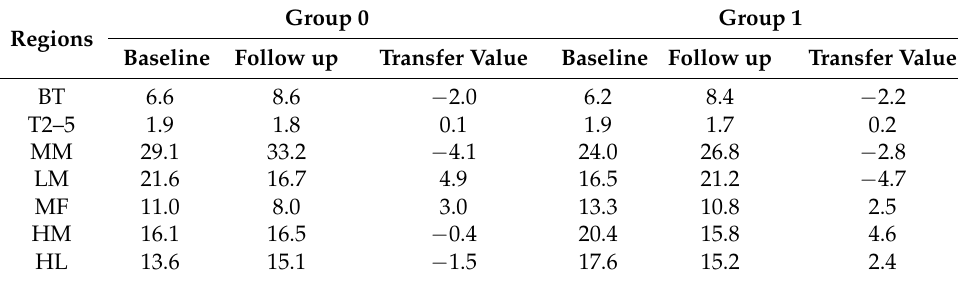
Table 4. FTIrel (%) and the transfer